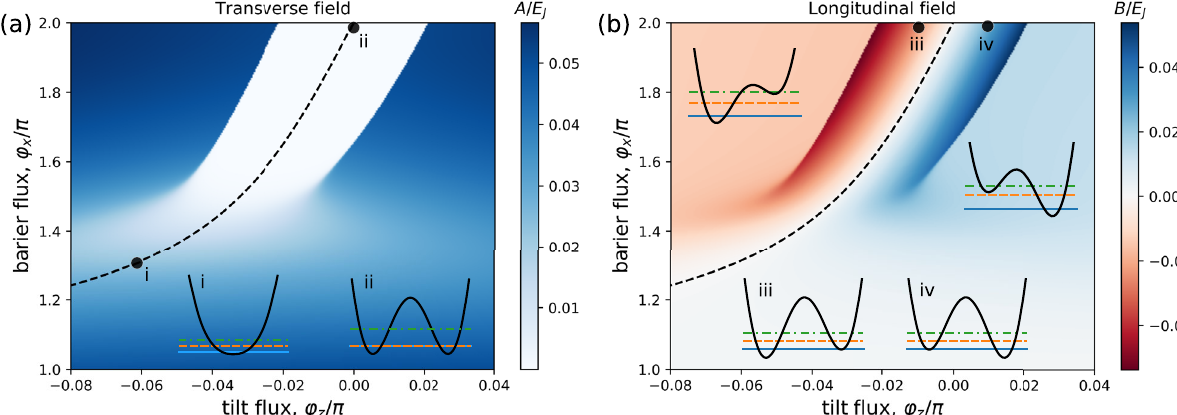
Fig. 2 Numerically calculated transverse fi eld Ising Hamiltonian coef fi cients (Eq. (3)) as a function of fl ux biases. a Transverse fi eld coef fi cient A ( t ) for σ x . Filled circle (i) marks the bias values corresponding to A (0) for which there is only a single well (inset i) and the transverse = 0 corresponding to A ( t fi eld is large, and (ii) marks the bias values at the degeneracy point φ f ) for which the barrier is high (inset ii) and the z tunneling between the symmetric wells is suppressed; the lowest two levels (solid blue and dashed orange lines) are degenerate. An annealing path corresponds to moving from point (i) to point (ii), during which the barrier is raised. The dashed black lines show the location of the qubit ’ s degeneracy point (minimum gap). The reason for the skewed shape is the asymmetry effect described in the text. b Longitudinal fi eld coef fi cient B ( t ) for σ z . Filled circle (iii) marks the bias values for which the double-well potential is tilted to the left (inset iii) and the longitudinal fi eld is negative, and (iv) marks the values for which the double-well potential is tilted to the right (inset iv) and the longitudinal fi eld is positive. For very large tilt values, outside of the boundaries de fi ned by the sharp color transition, the fi rst two eigenenergies are both localized in the same well, as illustrated by the insets inside panel ( b ). When this happens the Ising mapping no longer applies and the circuit cannot be used as a fl ux qubit. For our parameters, E J /2 π ≈ 100 GHz.